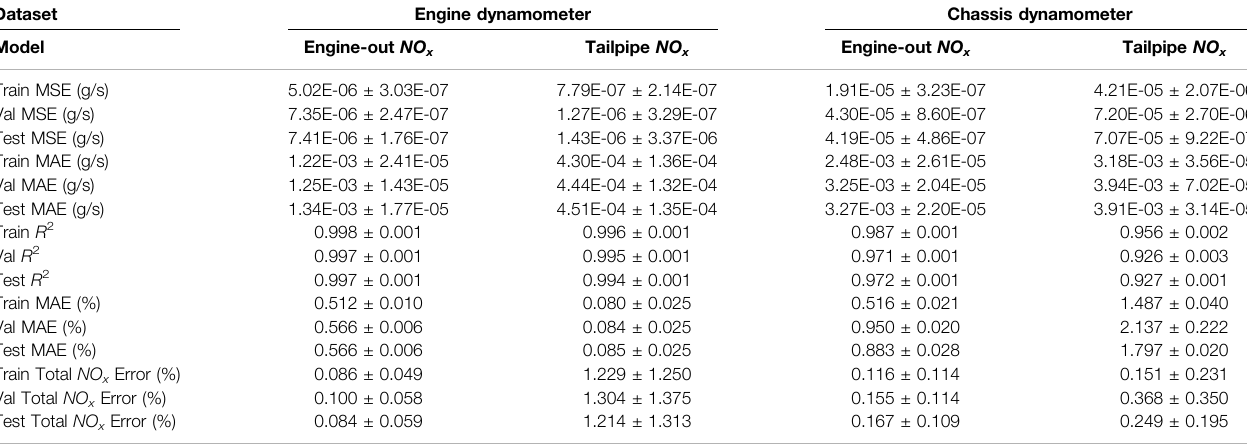
TABLE 4 | Evaluation metrics for train, validation and test set with 95% con fi dence intervals (all